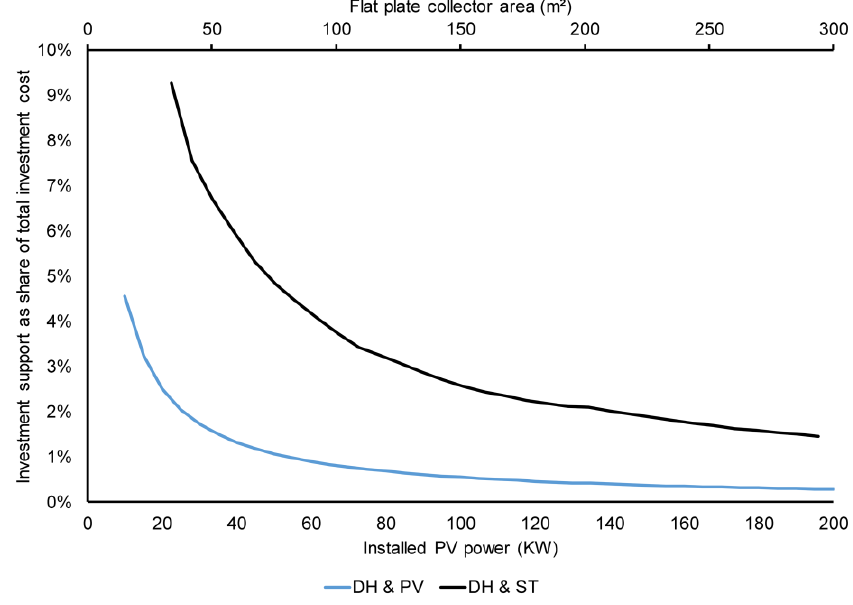
Figure 9. Investment support as share of total DEG system cost for building heated with DH.